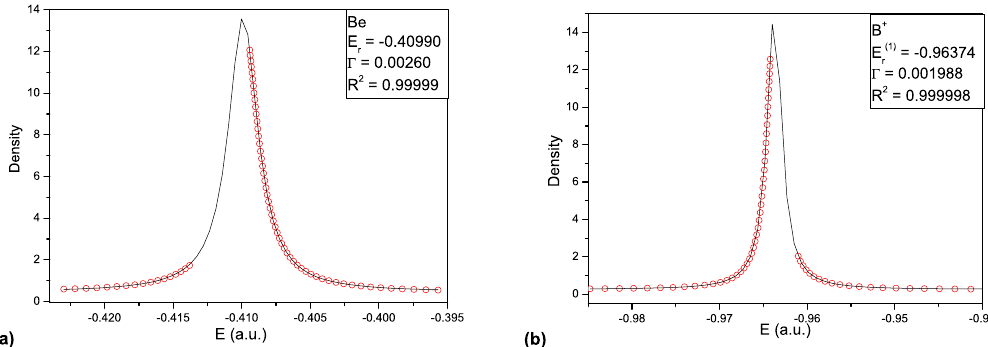
Figure 1. The density of resonance states fitted to the Lorentzian form corresponding to the lowest resonance, as indicated in Figures 2a,b, respectively. The circles are the calculated values and the solid line is the fit function. The resonance parameters are shown in the box in the top right corner. ( a ) Be, ( b ) B + .